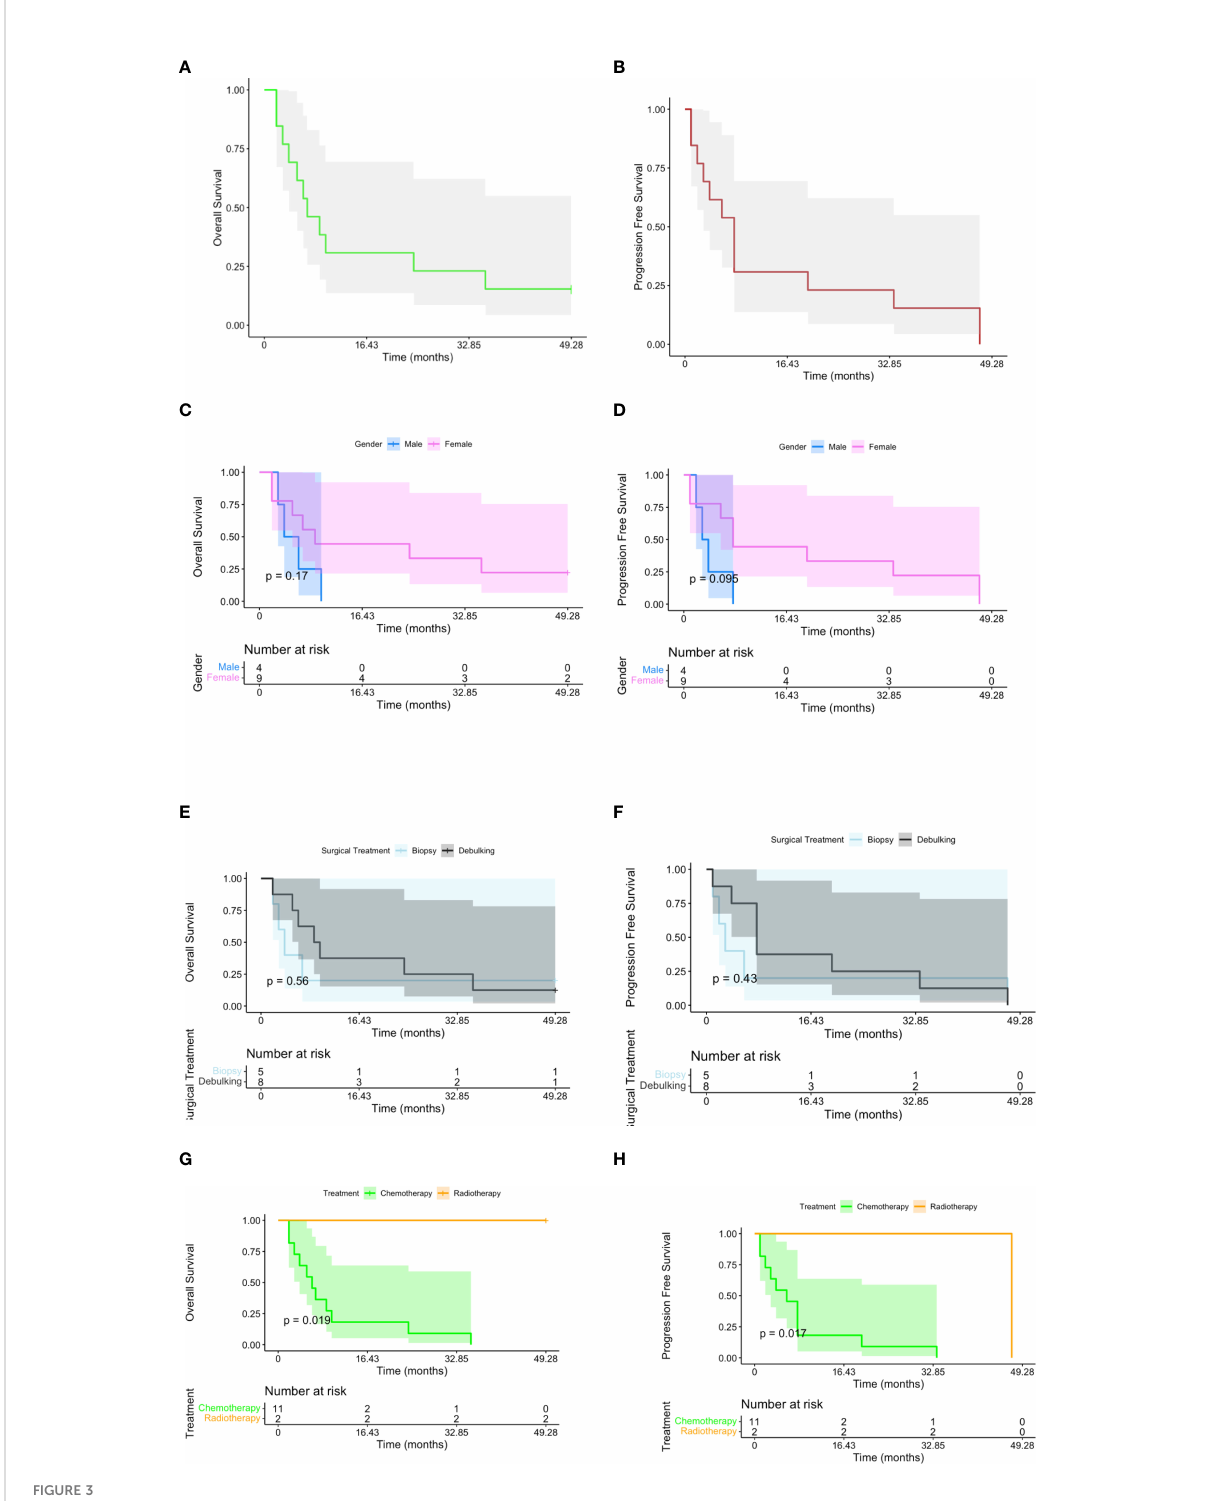
FIGURE 3 Kaplan – Meier plots reporting overall survival (OS) and progression-free survival (PFS) for all the subjects included in the study (A , B) . OS and PFS have been strati fi ed, respectively, by gender (C , D) , surgical treatment (E , F) , and postoperative therapy [ G ( p -value < 0.02), H ( p -value <